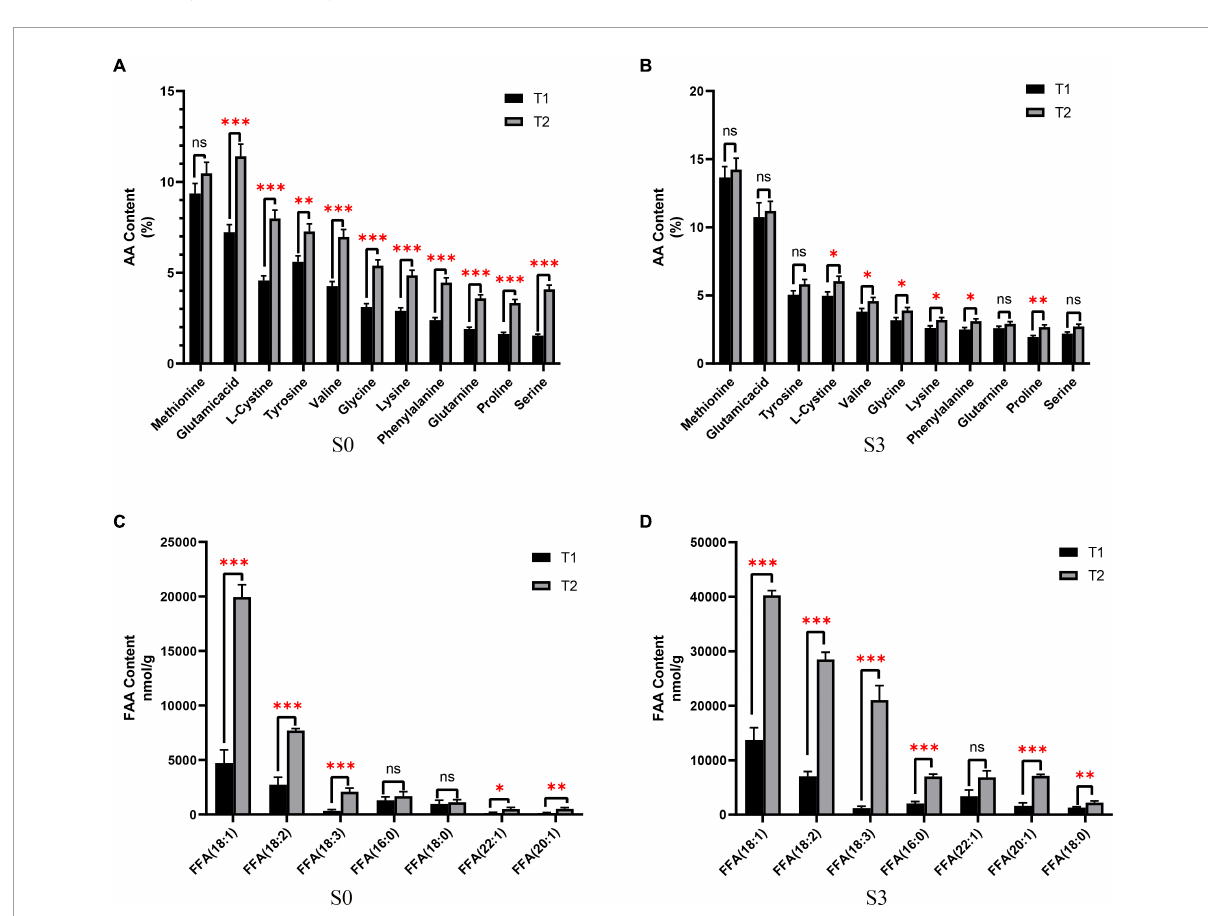
FIGURE1 The content of amino acids (AA) and free fatty acids (FFA). (A) AA content of fermented rapeseed cake in S1. (B) AA content of fermented rapeseed cake in S3. (C) FFA content of fermented rapeseed cake in S1. (D) FFA content of fermented rapeseed cake in S3. * p < 0 . 05; ** p < 0 . 01; *** p < 0 .